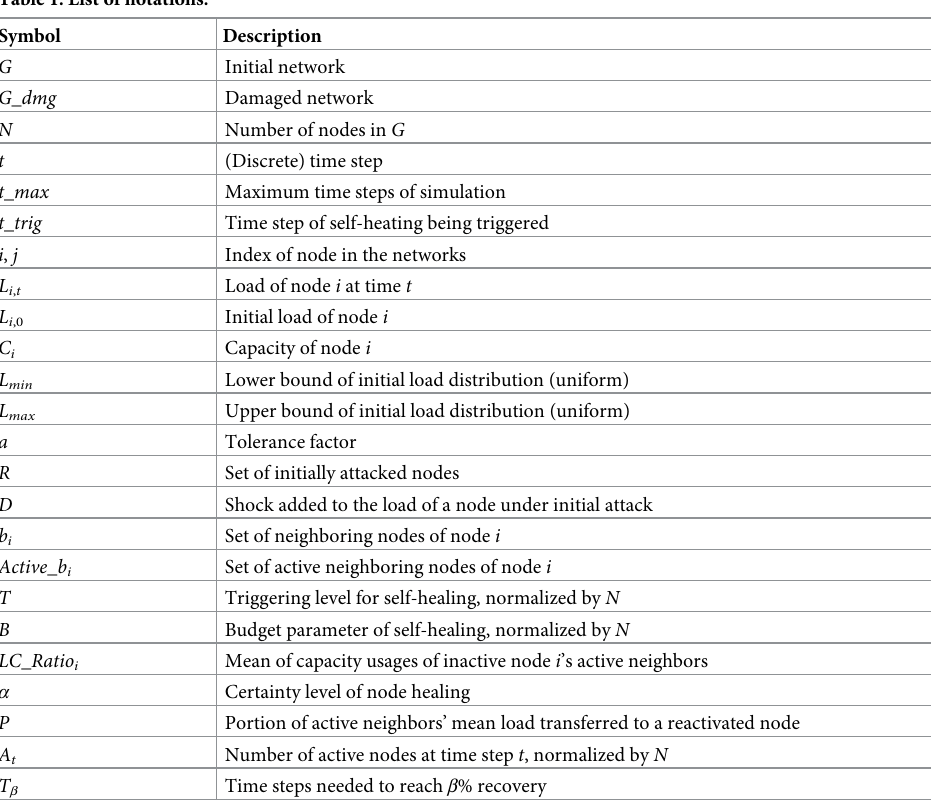
Table 1. List of